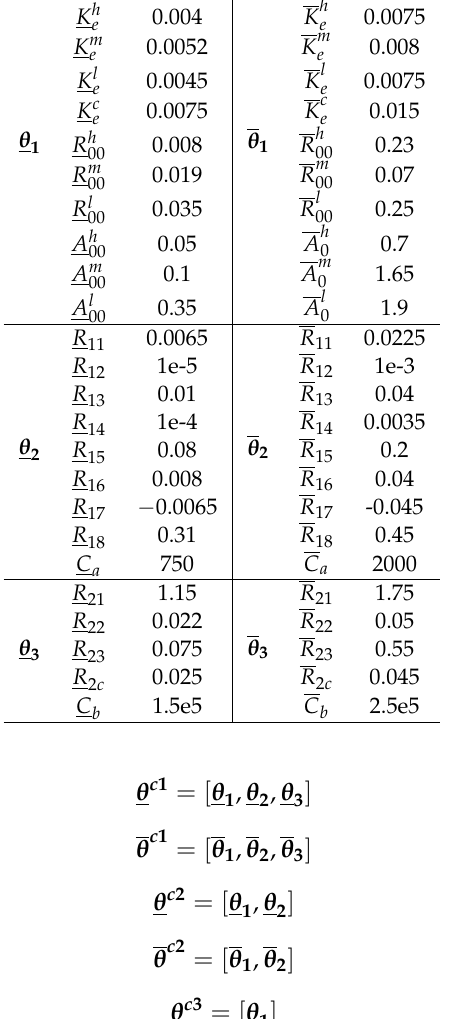
Table 4. Parameter search